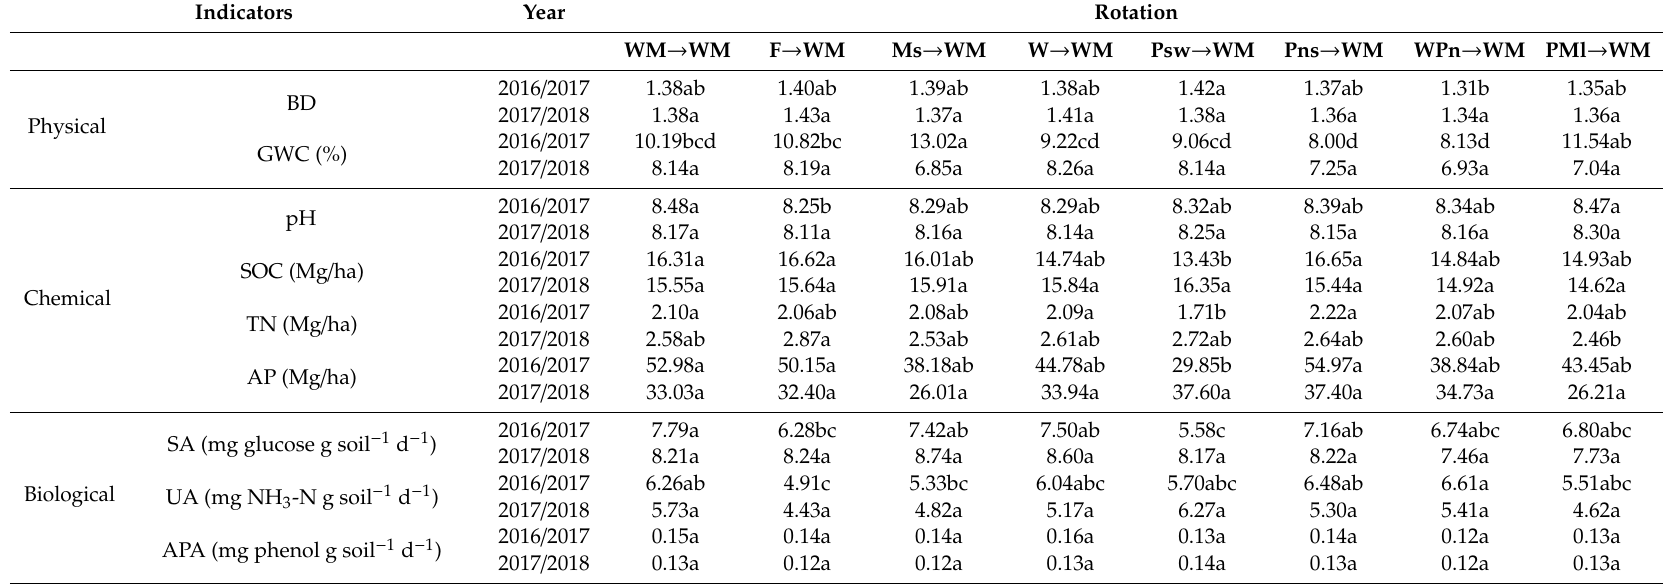
Table 2. Selected soil health indicators of eight rotations in the two years at 0–20 cm soil